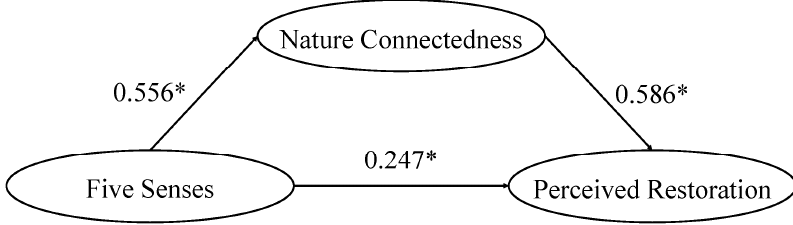
Figure 1. Mediating Effect of Nature Connectedness. * p <